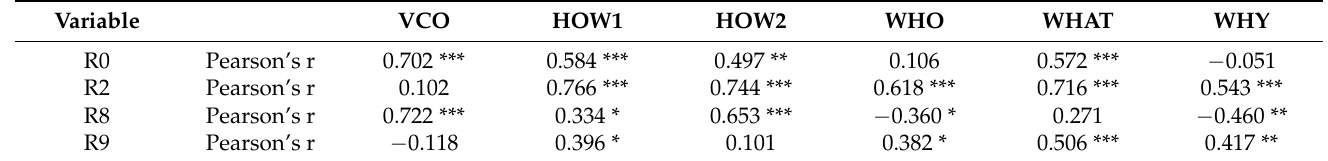
Table 5. Pearson’s partial correlations among BM elements and CE strategies of CR